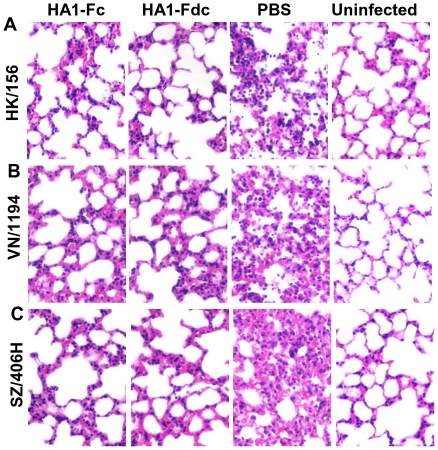
Evaluation of histopathological changes in lung tissues of H5N1 virus-challenged mice.HA1-Fc- and HA1-Fdc-vaccinated mice were challenged with 10 LD50 of three clades (clade 0: HK/156, clade 1: VN/1194, and clade 2.3.4: SZ/406H) of H5N1, and lung tissues were collected at day 5 post-challenge. Lung tissues from mice injected with PBS and those of uninfected mice were used as negative and normal controls, respectively. All sections of lung tissues were stained with hematoxylin and eosin (H&E) and observed under light microscope (magnification, 100×). Representative image of histopathological damage from mice challenged with HK/156 (A), VN/1194 (B), and SZ/406H (C) H5N1 virus was shown.